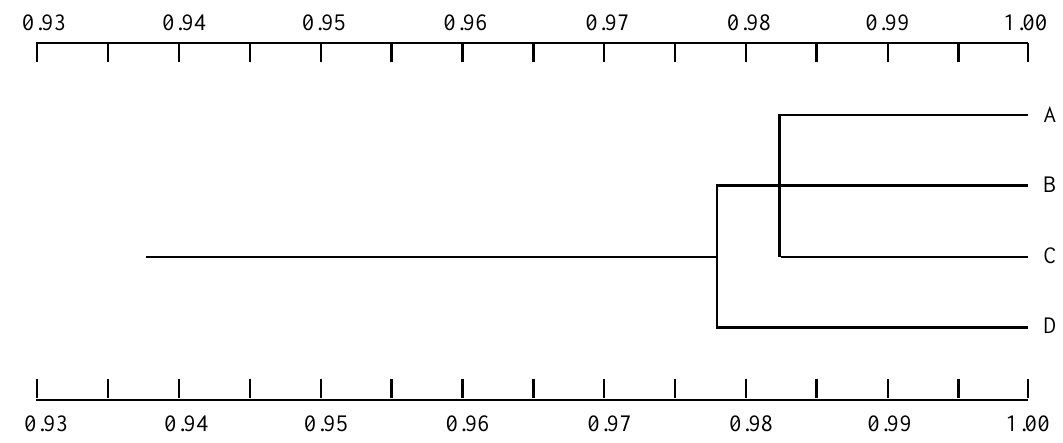
Figure 2 - Dendrogram resulting from grouping populations on the basis of genetic similarity by the unweighted pairing group method with arithmetic mean (UPGMA), determined by Nei (1978). A, Ariquemes; B, Cachoeira Porteira; C, Porto Velho/Samuel, and D, Manaus.